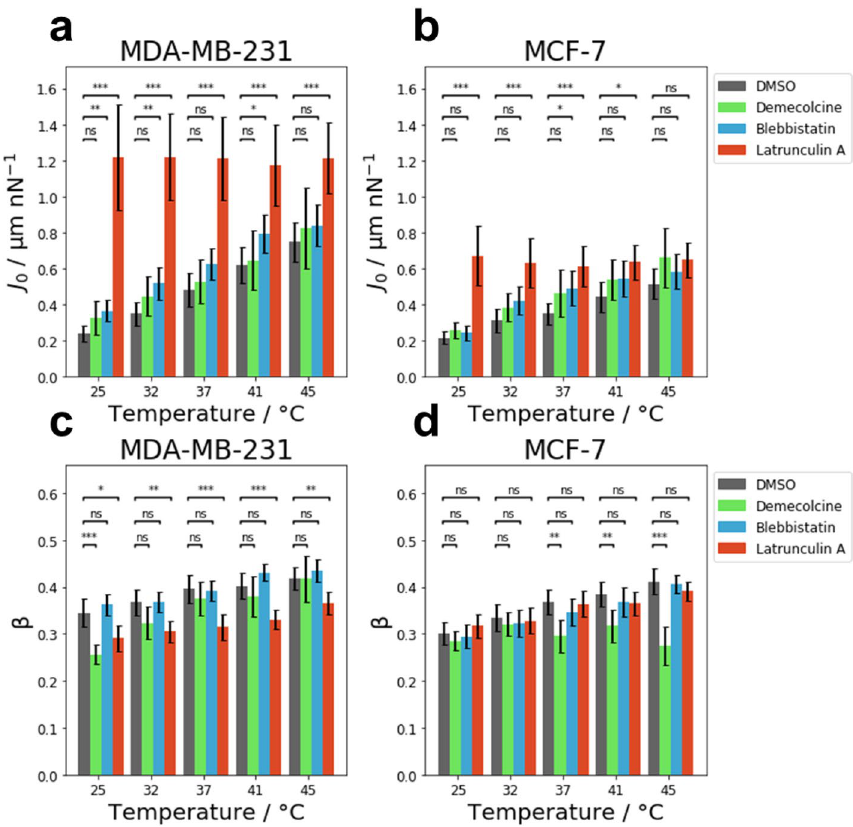
Figure 5. Comparison of the effect of treatment with Demecolcine, Blebbistatin and Latrunculin A on the mechanical properties for MDA-MB-231 and MCF-7 cells at different temperatures. Creep compliance of ( a ) MDA-MB-231 and ( b ) MCF-7 cells was not affected by Demecolcine at any temperature, while Latrunculin A and Blebbistatin affected the creep compliance of both cell lines. Cell fluidity β of ( c ) MDA-MB-231 cells and ( d ) MCF-7 cells was not affected by Blebbistatin at any temperature. Latrunculin A only affected the cell fluidity of MDA-MB-231 cells but not MCF-7 cells. Demecolcine displayed a different temperature dependent effect on the cell fluidity of MDA-MB-231 and MCF-7